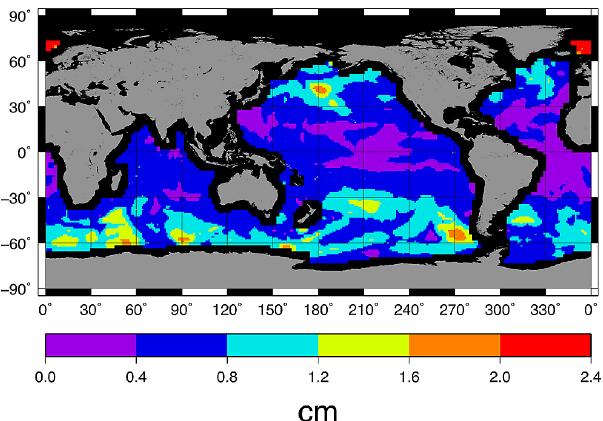
Fig. 12. Percent of variance reduced using new optimal destrip- ing parameters and 500km smoothing compared to those used for RL04, also using 500km Gaussian smoothing. Positive values mean the variance with the new algorithm is reduced, negative values mean that variance is